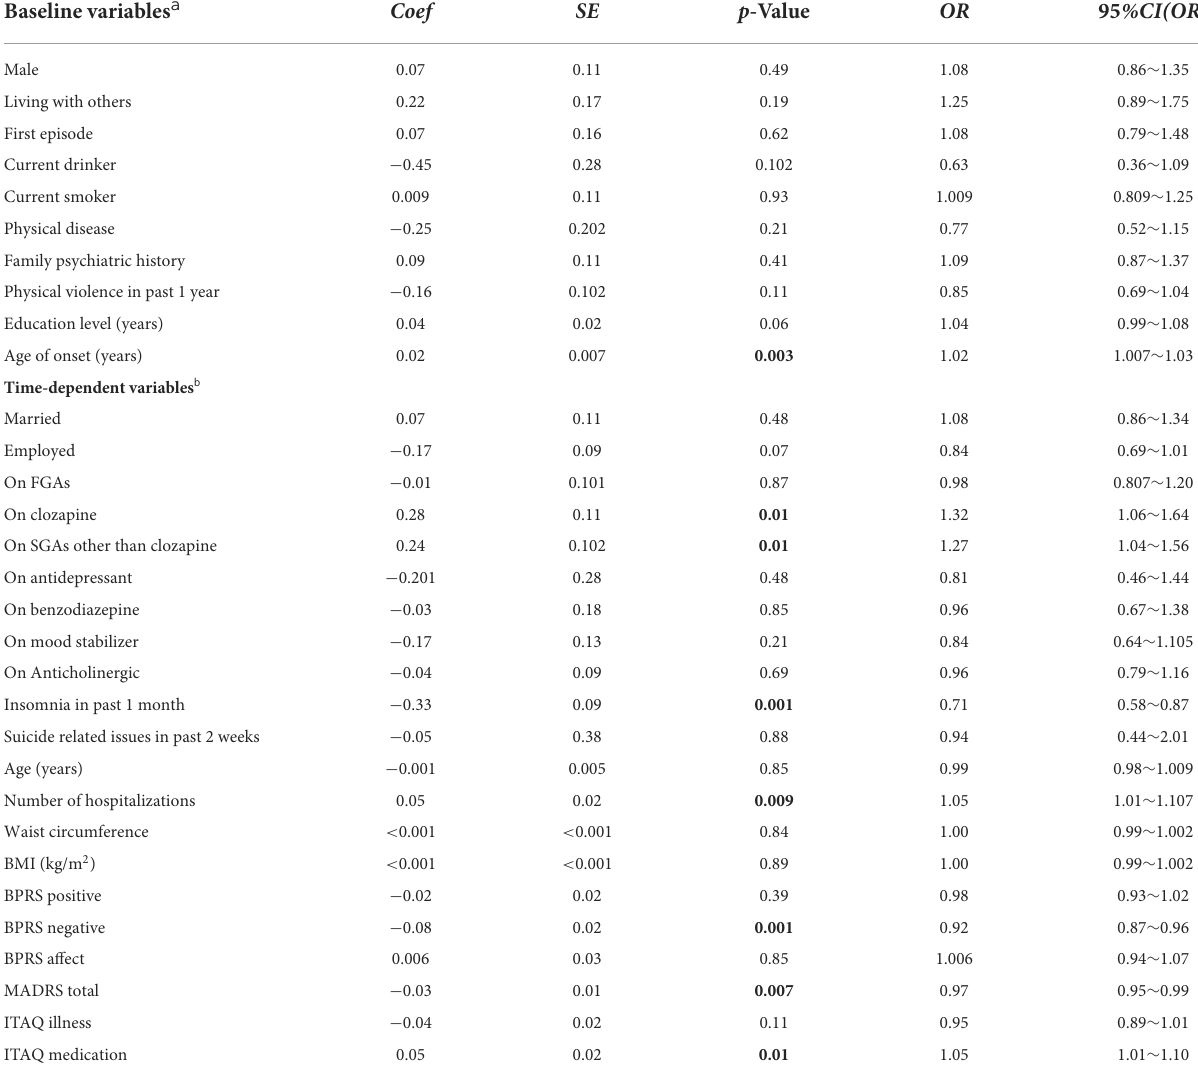
TABLE 7 Generalized Estimating Equations (GEE) results modeling risk factors associated with WHOQOL environment domain in 491 patients with schizophrenia. Baseline variables